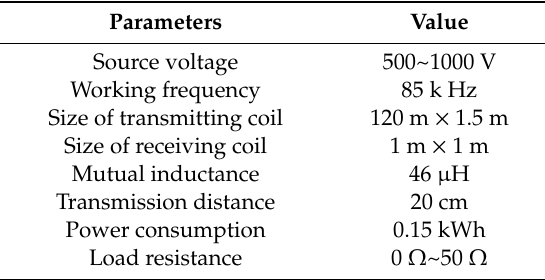
Table 1. Electric vehicle (EV) dynamic wireless power transmission (DWPT) charging system